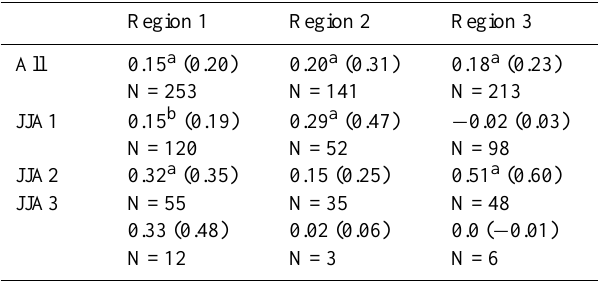
Table 1. JJA O 3 -CO slope (mol mol-1), correlation coefficient ( r ) and sample size (N) for circulation types in the three regions shown in Fig. 3a. The superscripts a and b indicate slope significance at the p =0.01, and 0.05 levels respectively. The slopes without super- scripts had p values greater than 0.10 and were thus not considered significant to a high degree but are shown for